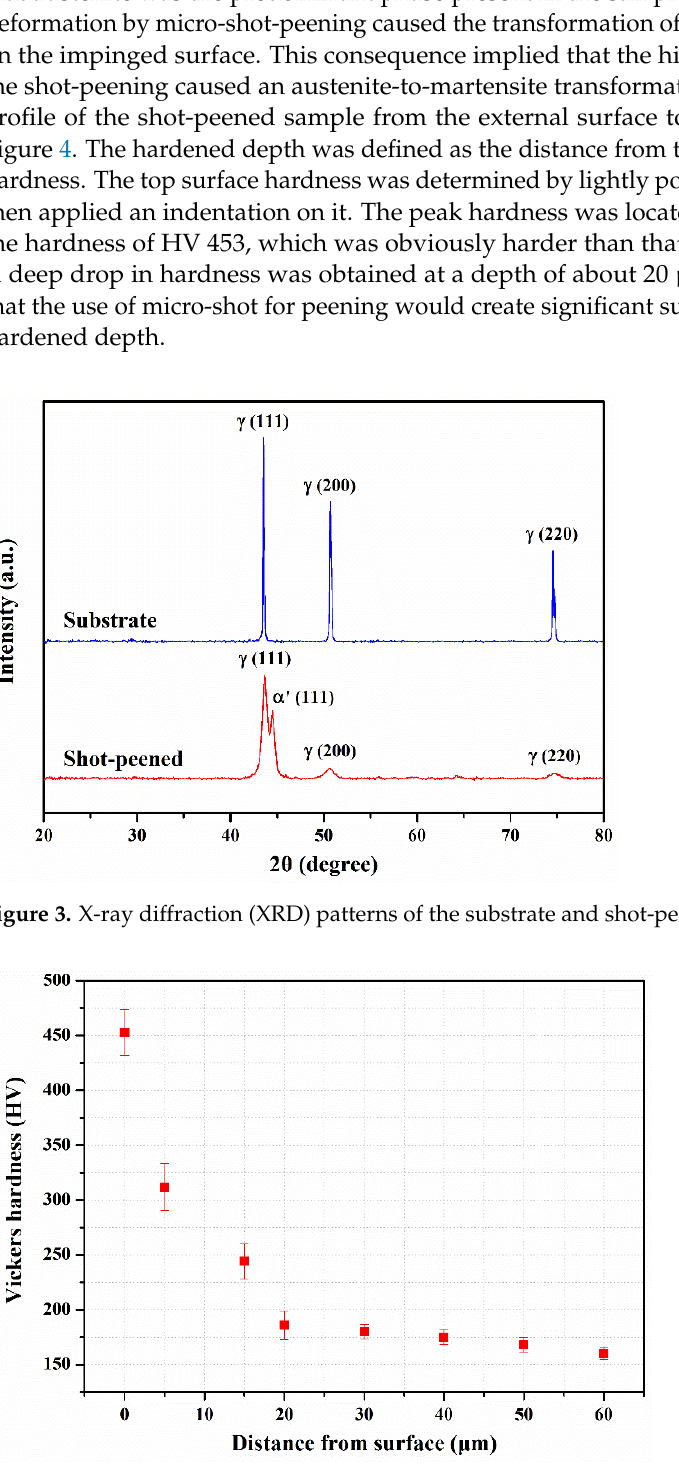
Figure 4. Hardness depth profile of the shot-peened sample.